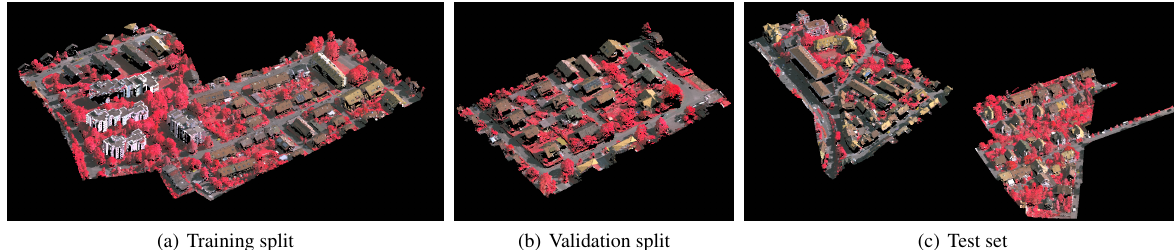
Figure 2. ISPRS Vaihingen 3D Semantic Labeling data set. The point clouds are colored based on a CIR